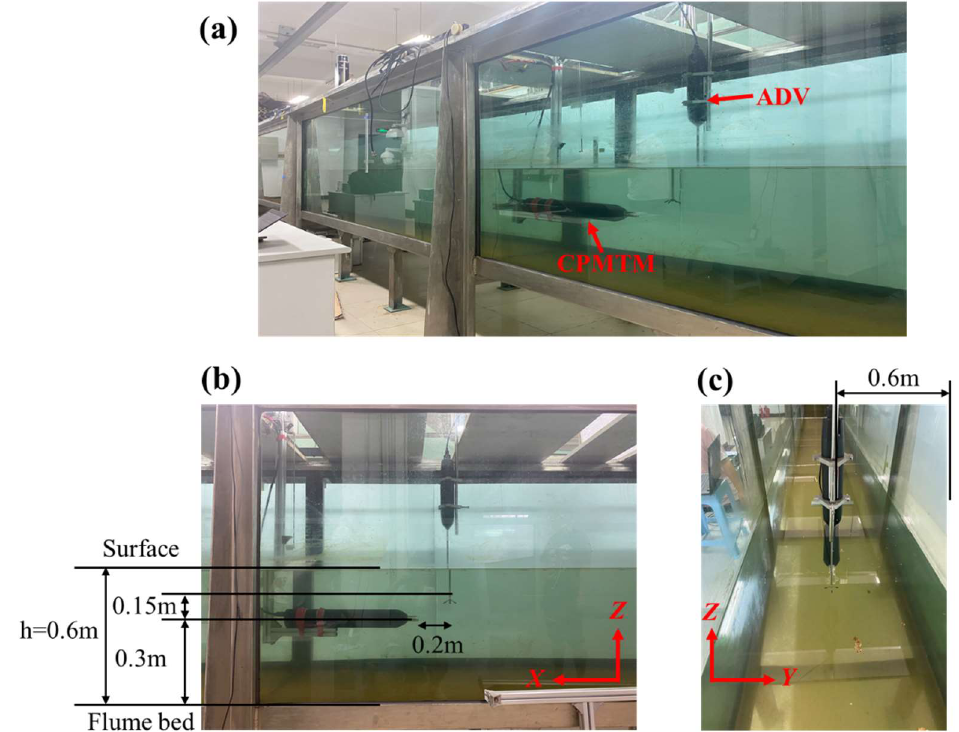
Figure 3. General view of laboratory experiment. ( a ) shows the schematic of the recirculating flume and the equipment installation; ( b ) the elevation view of the experimental setup and sampling location; ( c ) the side view of panel ( b ).